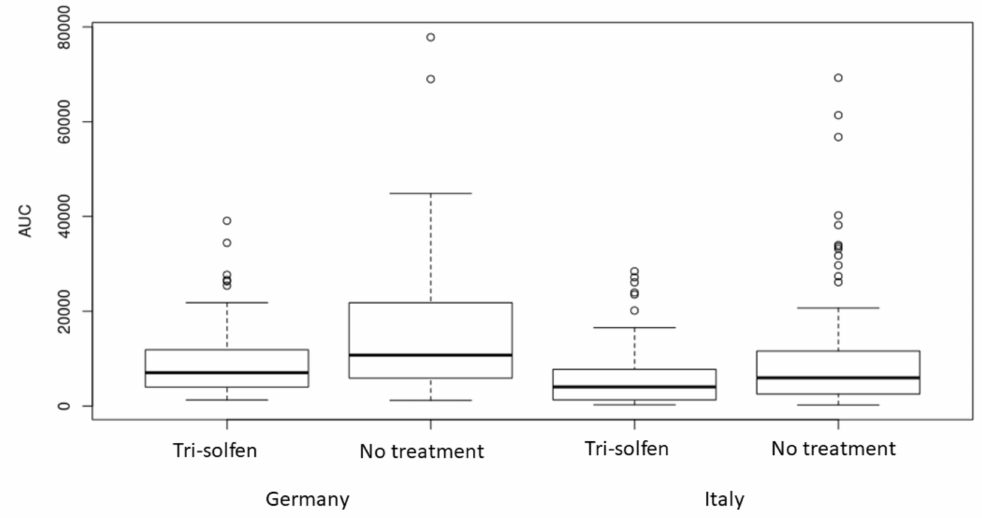
Figure 3. Box plot of total vocal responses (AUC) calculated from area under the dB/time waveform using image analysis (Pxls) (encompassing vocal response from commencing traction on the first spermatic cord until 1 s following removal of the second testicle in each piglet), displayed by treatment group and site. White circles are